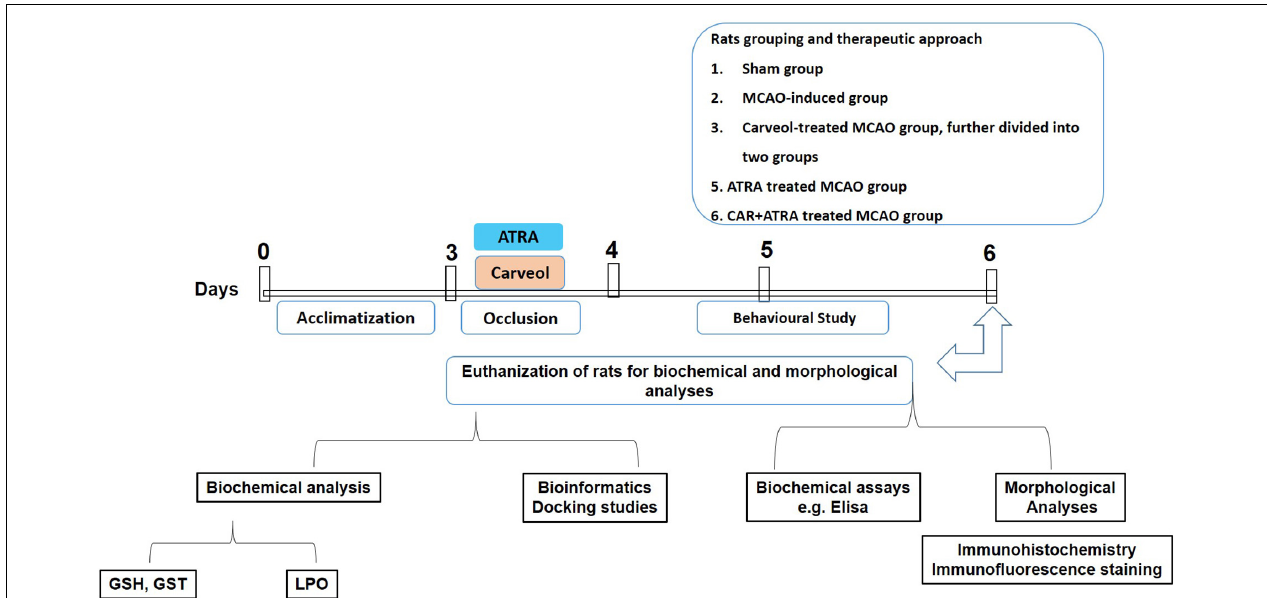
FIGURE 1 | Schematic representation of the in vivo study design. Rats acclimatization, MCAO surgery, drug administration, neurobehavioral studies, euthanization of rats for tissue collection to carry out biochemical analysis, i.e., GST, GSH, catalase and lipid peroxidation (LPO), morphological analysis (2,3,4-triphenyl tetrazolium chloride staining, hematoxylin, and eosin staining and immunohistochemistry), and biochemical assay (enzyme-linked immunosorbent assay, ELISA).